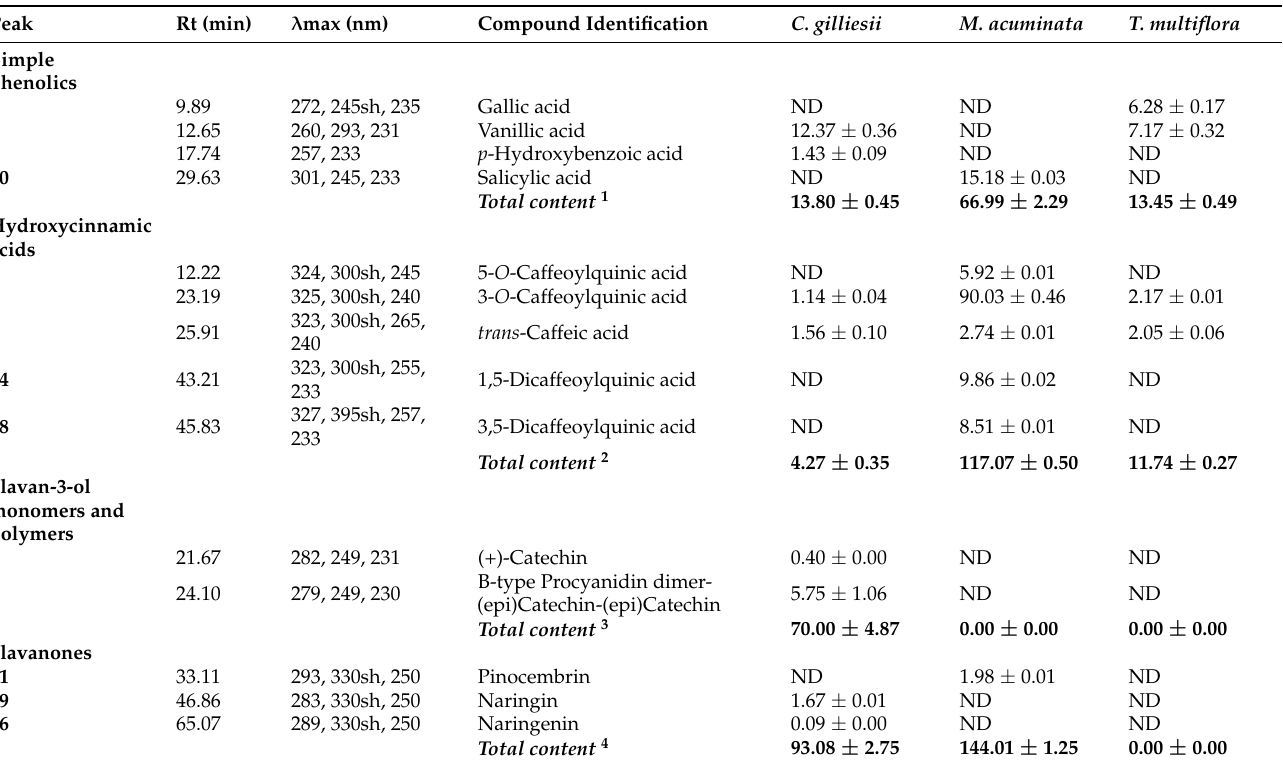
Table 1. Tentative identification and content of phenolic compounds from PEEs of C. gilliesii , M. acuminata , and T. multiflora